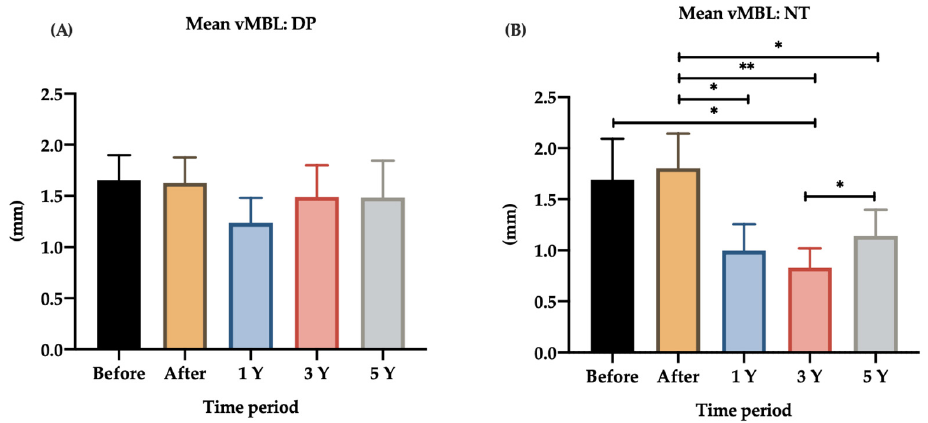
Figure 5. Bar chart of the mean vMBL around PS dental implants opposing DP and NT. vMBL, vertical marginal bone level; DP, dental prostheses; NT, natural teeth; 1 Y, 1-year follow-up; 3 Y, 3-year follow-up; 5 Y, 5-year follow-up. * p < 0.05; ** p < 0.01. ( A ) Mean vMBL in the DP group; ( B ) mean vMBL in the NT group (before vs. 3-year loading, p = 0.023; after vs. 1-year loading, p = 0.011; after vs. 3-year loading, p = 0.003; after vs. 5-year loading, p = 0.029; 3-year vs. 5-year loading, p = 0.023). For dental implants opposing NT, the average hMBL was 1.34 ± 0.23 mm at baseline and 1.45 ± 0.22 mm immediately after loading. PS dental implants were significantly more likely to lose bone if they were opposed by NT (before vs. 3-year loading, p = 0.002; before vs. 5-year loading, p = 0.002), whereas the PS dental implants opposed by DP did not reach significance (before vs. 3-year loading, p = 0.641; before vs. 5-year loading, p = 0.762).